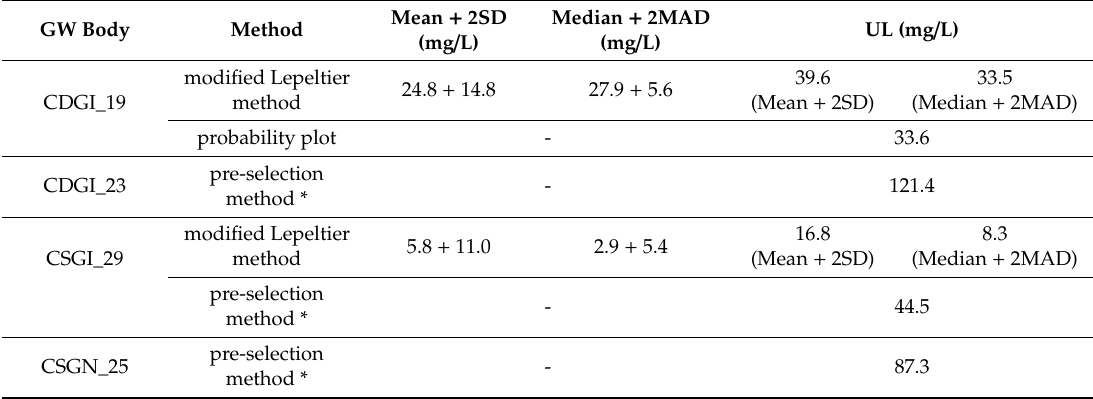
Table 6. Estimated Mean + 2SD and Median + 2MAD ranges (for modified Lepeltier method) and the upper limits of ranges of ambient background concentrations (UL) of sulphate (SO 4 ) obtained by selected methods. EU Drinking Water Standard for SO 4 is 250 mg/L.